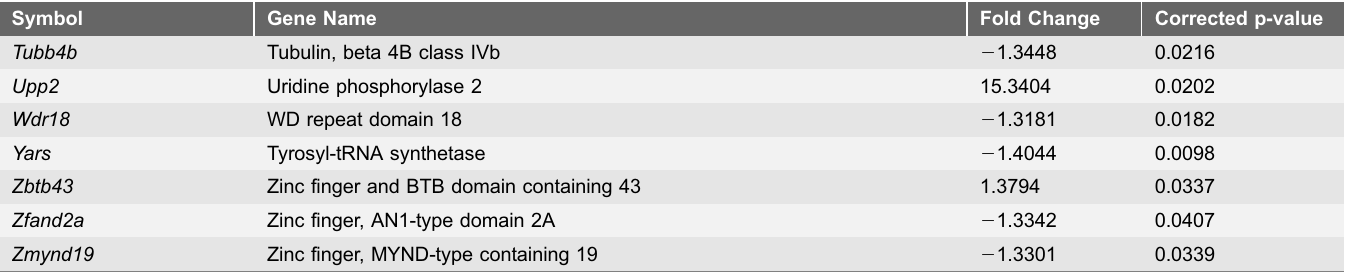
to dimethylallyl diphosphate (DMAPP). Idi1 and Idi2 are both peroxisomal (blue- pink ovals). DMAPP is condensed to geranyl diphosphate and to farnesyl diphosphate. Both reactions are catalyzed by either farnesyl diphosphate synthase ( Fdps , 2 1.44 fold change) or geranylgeranyl diphosphate synthase 1 ( Ggps1 , not altered). Alternatively, IPP can be converted to geranylgeranyl diphosphate by Ggps1 . A third option is the conversion of IPP to geranyl diphosphate and then to farnesyl diphosphate by Fdps . Lastly, IPP can be converted directly to farnesyl diphosphate by Ggps1 . All reactions culminate in the production of farnesyl disphosphate, which is then converted to presqualene diphosphate followed by squalene; both reactions are catalyzed by farnesyl diphosphate farnesyl transferase 1 ( Fdft1 , 2 1.55 fold change). Fdft1 is located in the endoplasmic reticulum. From there squalene epoxidase ( Sqle , 2 2.18 fold change) and lanosterol synthase ( Lss , 2 1.50 fold change), both lysosomal enzymes, convert squalene to squalene-2-3-epoxide and then to lanosterol. A series of three steps involving Cyp51 a cytochrome P450 gene ( 2 1.53 fold change), transmembrane 7 superfamily member 2 ( Tm7sf2 , not altered) and methylsterol monooxygenase 1 ( Sc4mol , 2 1.93 fold change) leads to the sequential conversion of lanosterol to 4,4-di(oxomethyl)cholesta-8,24-dienol. Following that, NAD(P) dependent steroid dehydrogenase-like ( Nsdhl , 2 1.18 fold change), emopamil binding protein (sterol isomerase) ( Ebp , 2 1.23 fold change) and sterol-C5-desaturase ( Sc5dl , 2 1.25 fold change) produce 7-dehydrodesmos- terol from 4,4-di(oxomethyl)cholesta-8,24-dienol. Then, 7-dehydrocholesterol reductase ( Dhcr7 , 2 1.94 fold change) and 24-dehydrocholesterol reductase ( Dhcr24 , 2 1.38 fold change) remove the C(7–8) double bond and delta-24 double bond, respectively, to produce cholesterol (black circle, bottom center). Dhcr24 may reduce the double bond in many of the cholesterol intermediates beginning with lanosterol, creating a variety of alternative steps. However, these alternatives are catalyzed by the same enzymes in the same order (lower half of Fig. 2). Our RNA-seq studies demonstrated that ethanol exposure down-regulated 15 of the 21 genes in the cholesterol biosynthesis pathway, including Hmgcr and Hmgcs1 . Three of these genes, Nsdhl , Ebp , and Sc5dl , were identified in our RNA- Seq data but were excluded from MetaCore analysis because they failed to